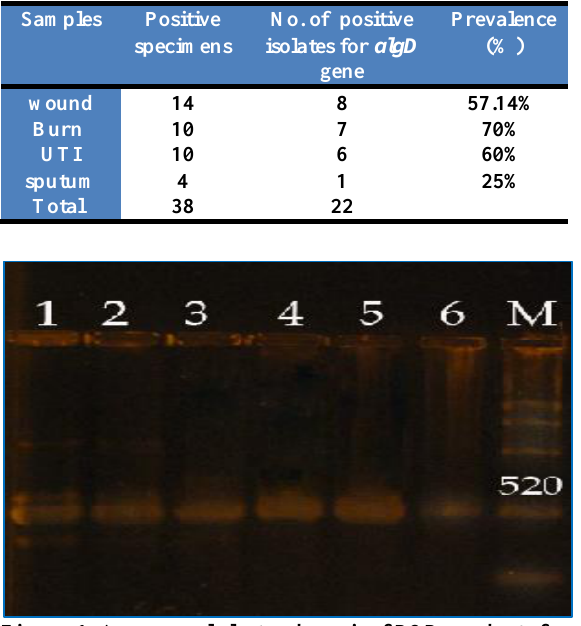
Table, 7: PCR results for alg D gene amplification in different clinical samples.